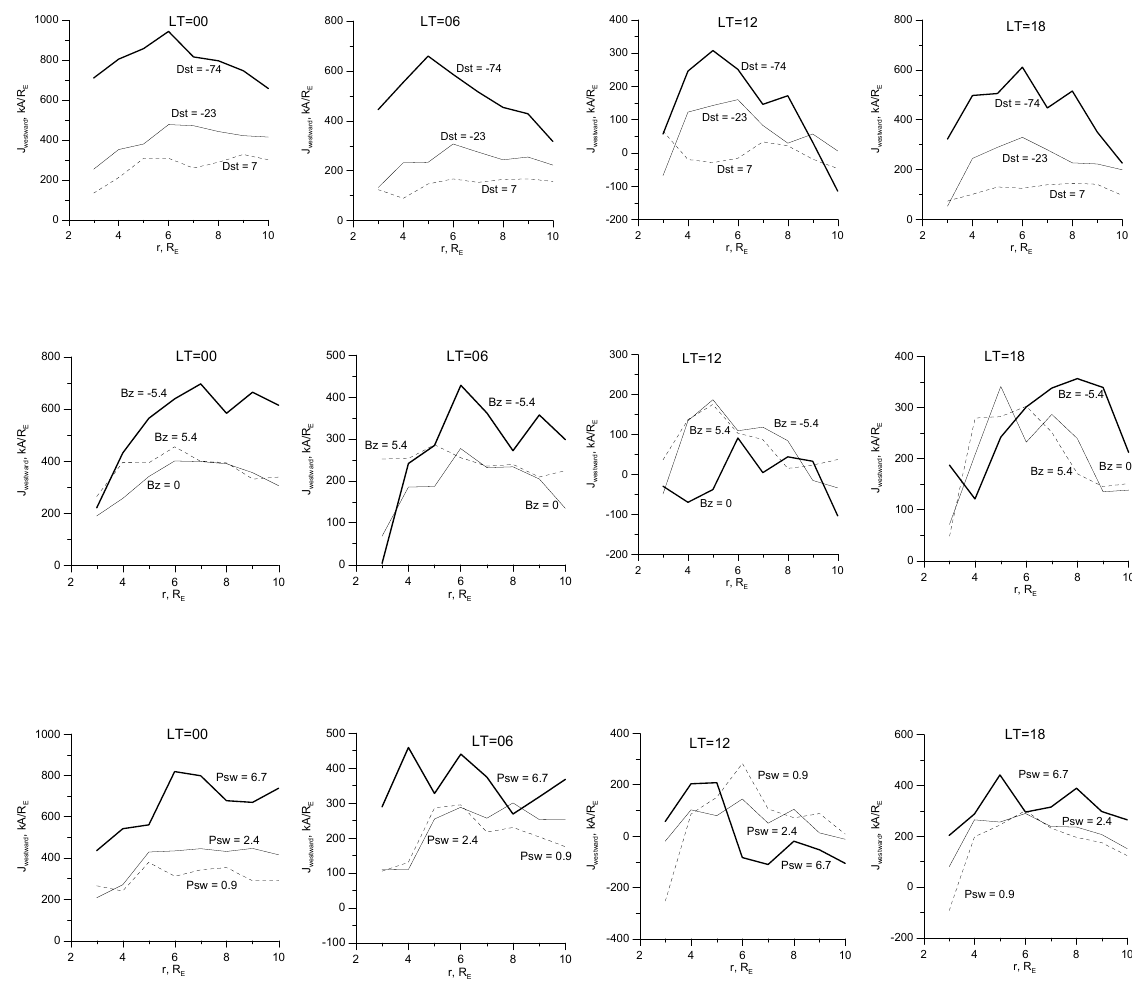
Fig. 2. Radial distribution of the westward electric current in different LT sectors under various (top) D st , (middle) B z IMF, and (bottom) P sw . The thick solid lines correspond to higher activity, the dashed lines correspond to lower one.